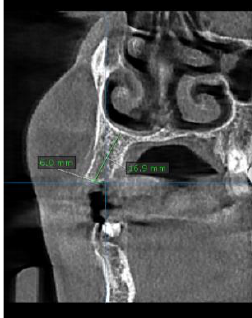
Figure 1: The CBCT cross section view with bone dimensions